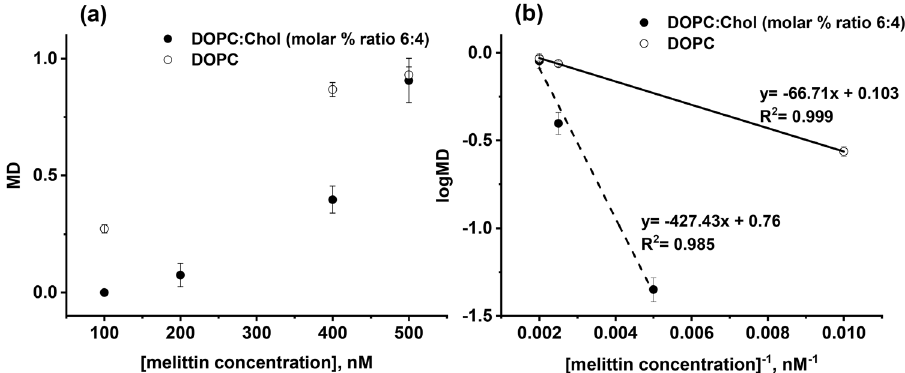
Figure 7. ( a )—Dependence of the membrane damage, MD, on melittin concentration, ( b )—same data depicted in logMD versus inverse of melittin